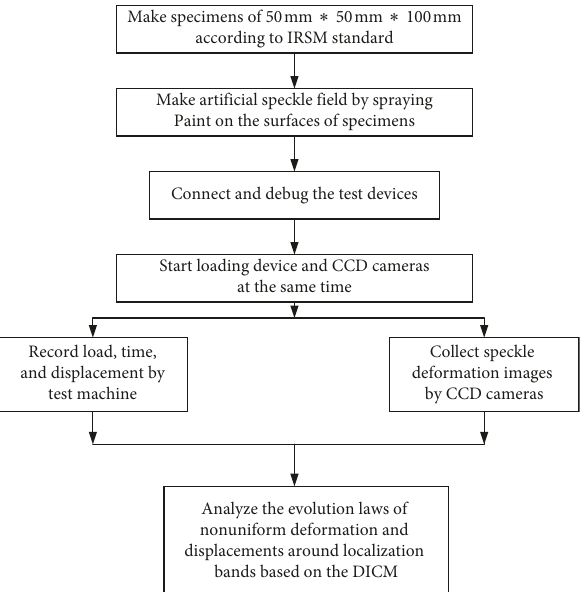
Figure 6: Flow chart of whole research process.